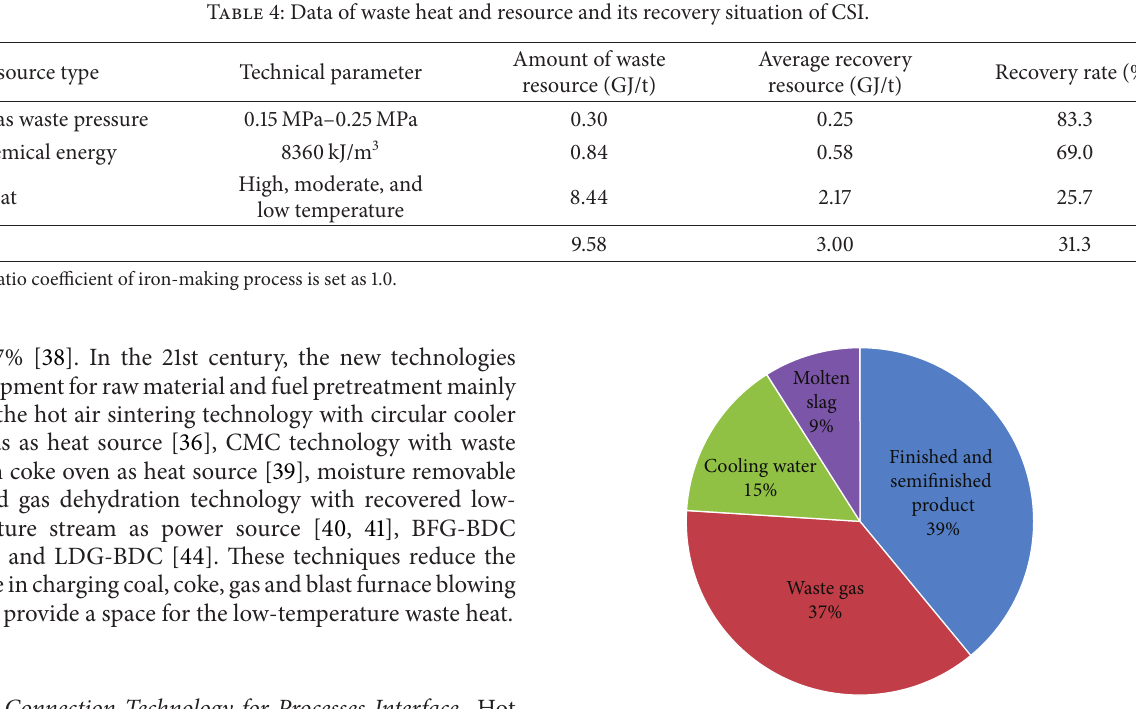
Figure 3: Waste heat resource structure of